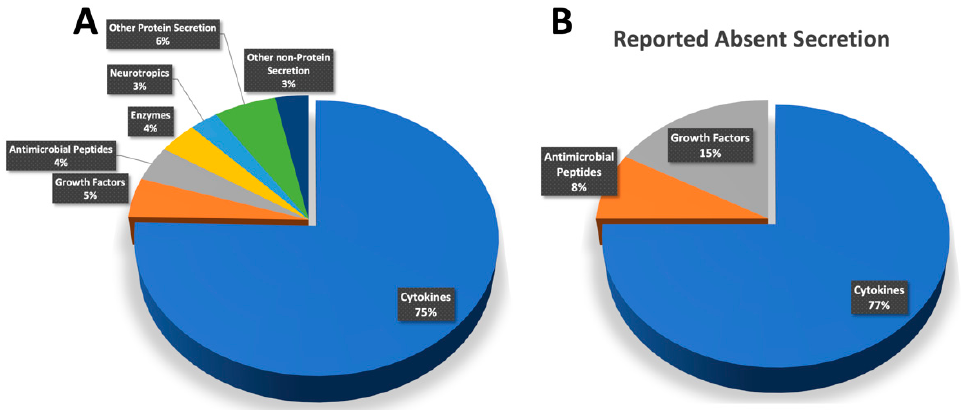
Figure 3. The reported present ( A ) and absent ( B ) secretions were mainly cytokines (75% and 75%, respectively), growth factors (6% and 17%, respectively), and antimicrobial peptides (5% and 8%, respectively).